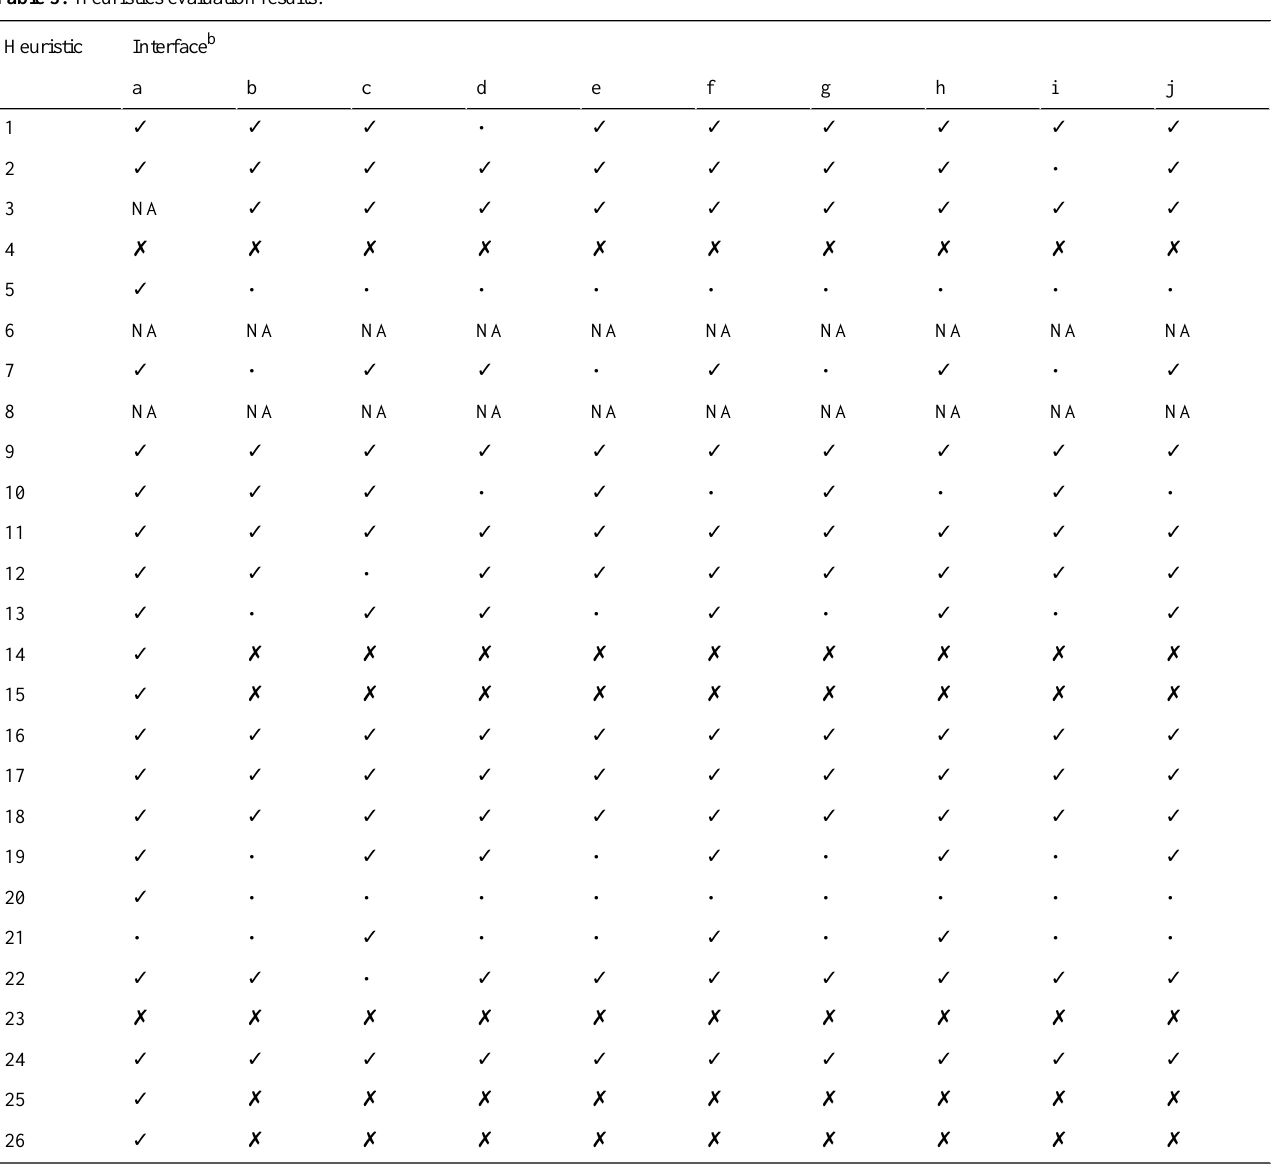
Table 3. Heuristics evaluation results.